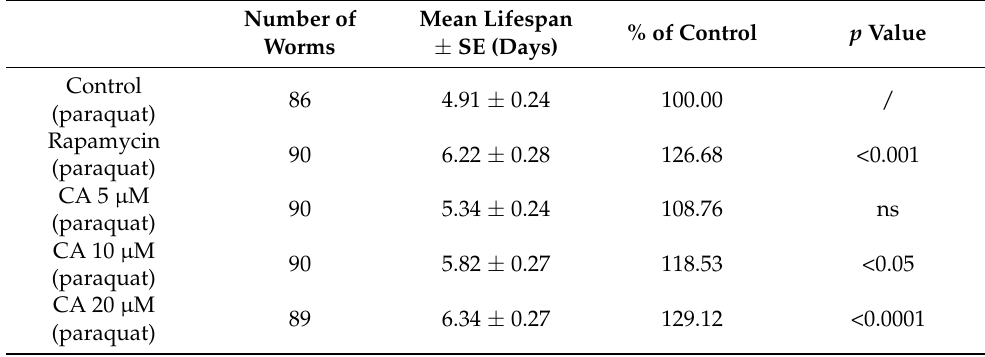
Table 4. Effect of CA on the mean lifespan of C. elegans with 37 ◦ C heat shock. Number of